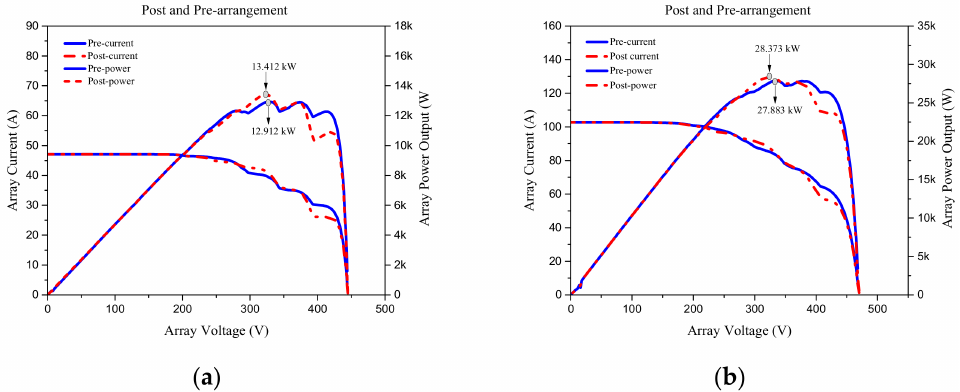
Figure 10. The outputs associated with the two types of 10 × 10 PV arrays, namely, 18-kW ( a ) and 43-kW ( b ) before and after the implementation of reconfiguration.